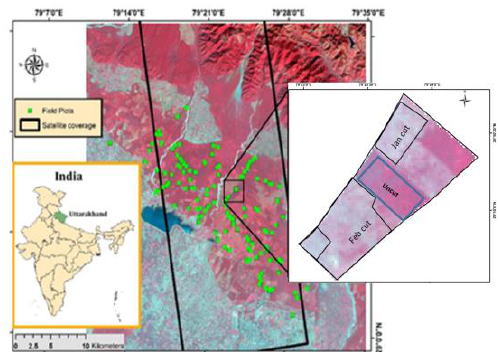
Figure 1 Study area showing Central Terai Forest